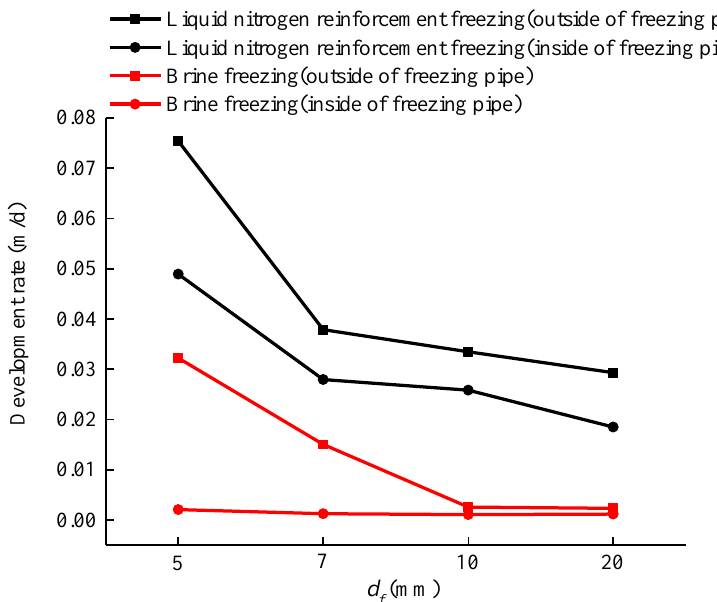
Figure 15. Development rate of frozen wall of fractured rock mass with different fracture apertures under liquid nitrogen reinforcement freezing.